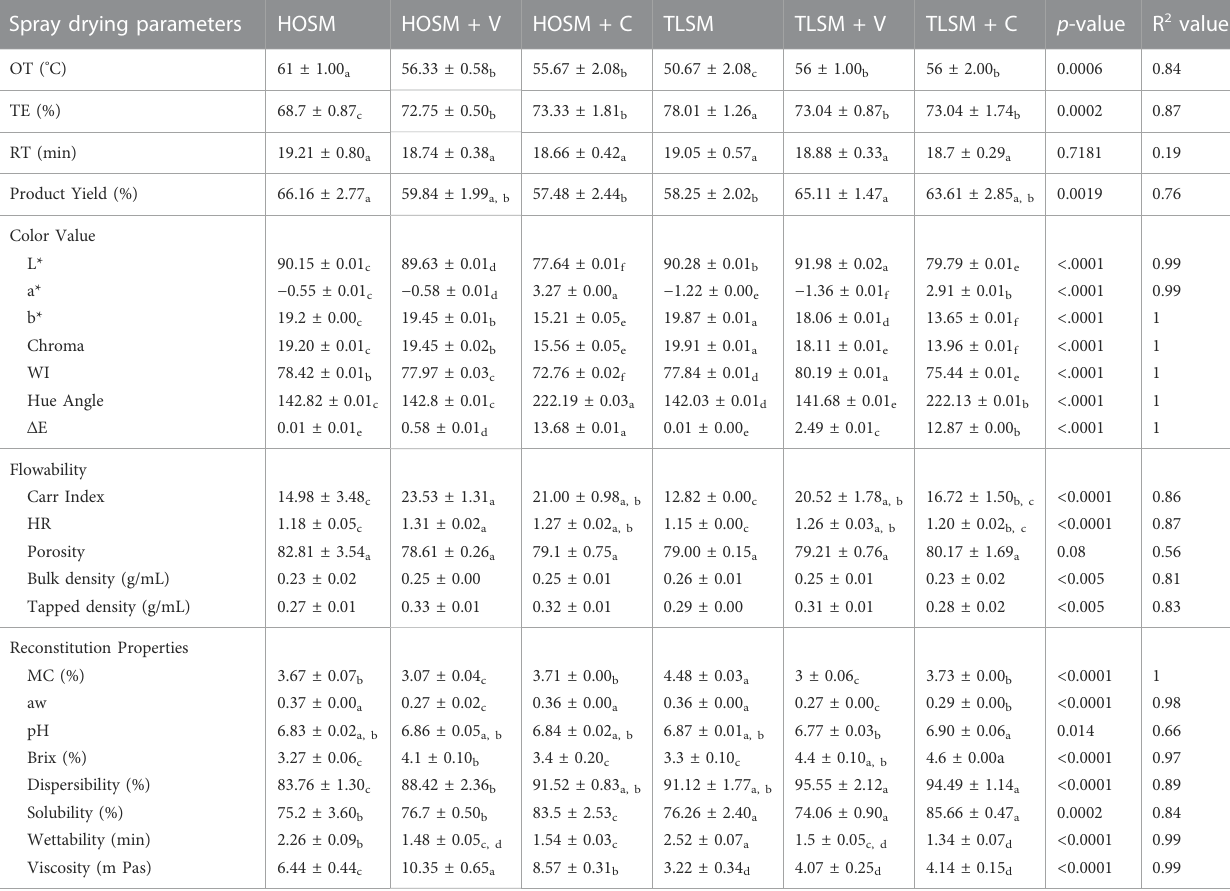
TABLE 1 Effect of change in fl avoring components on spray drying parameters and physicochemical properties of a spray-dried soymilk powder. Spray drying